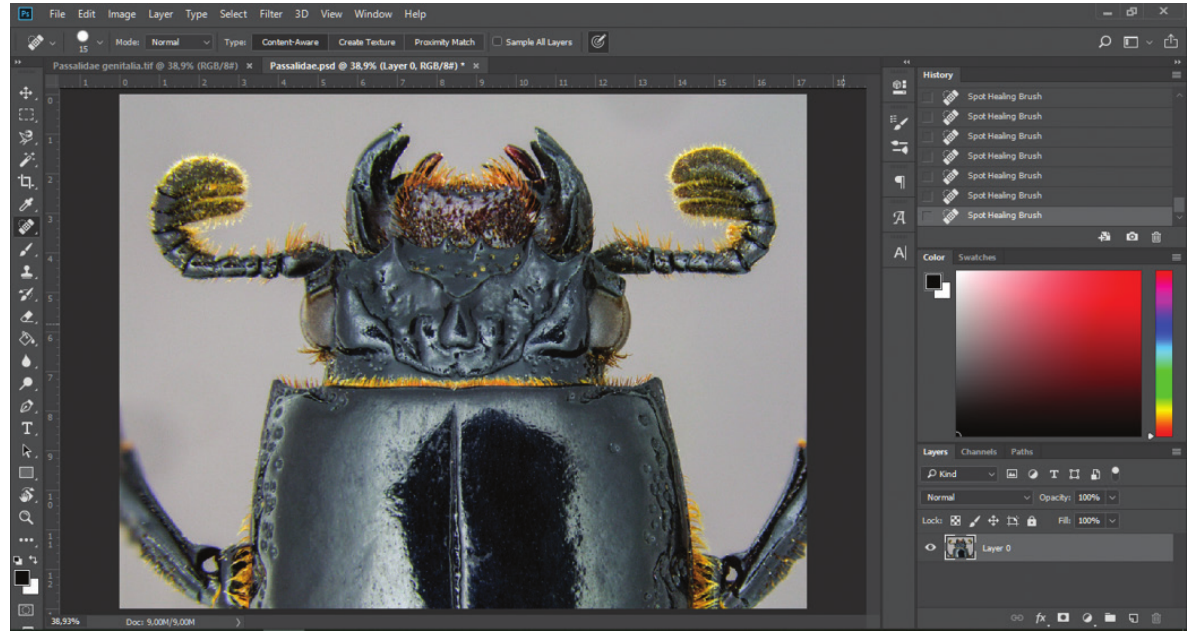
Figure 11. Image after editing and